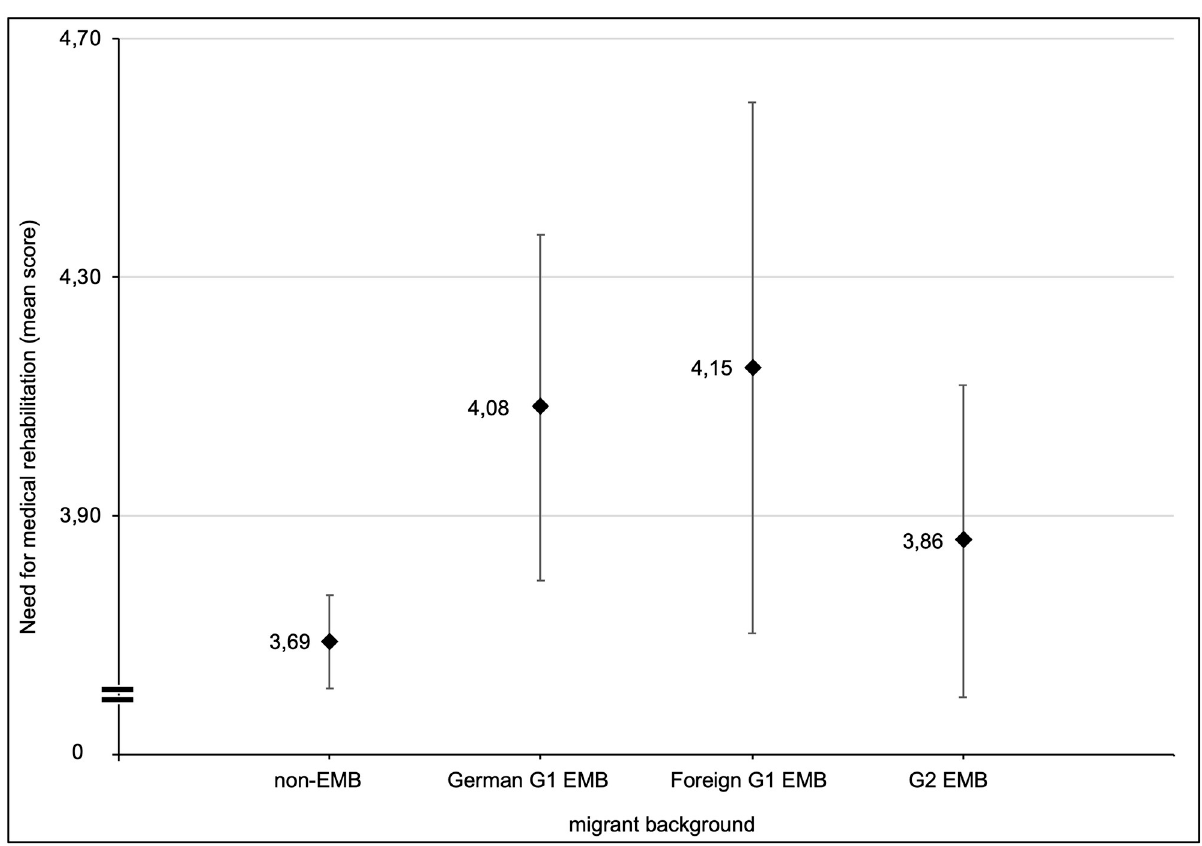
Fig 1. Arithmetic mean values and 95%-confidence intervals of the need score for rehabilitation in migrant groups (weighted results, n = 3897).